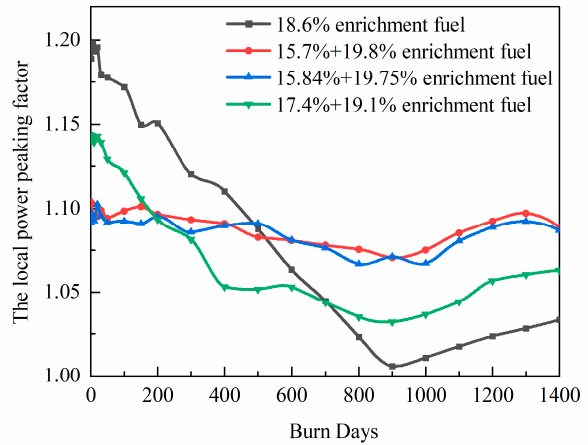
Figure 15. Trend of local power peaking factor with